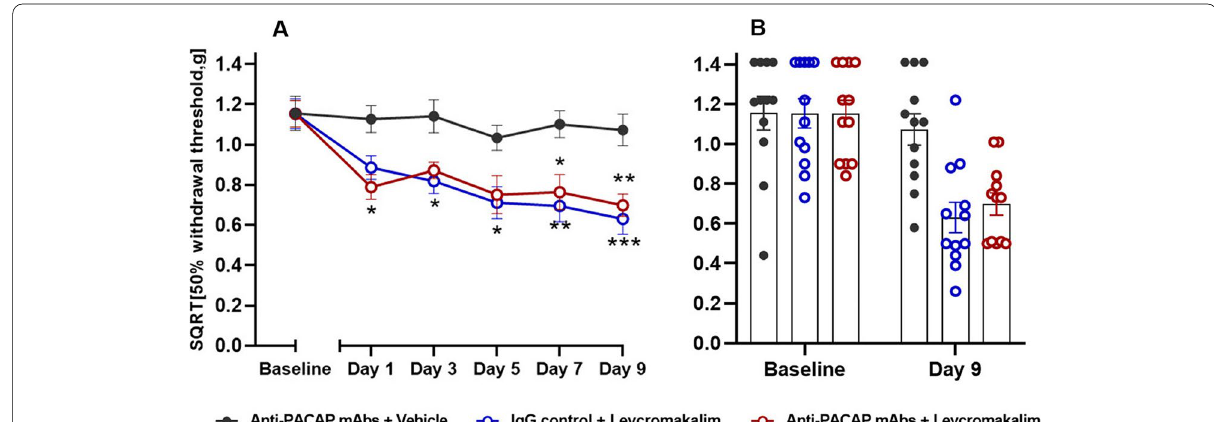
Fig. 4 Levcromakalim signaling independent from PACAP. Data are shown as 50% withdrawal threshold (g) and was square root transformed (SQRT). A Acute responses two hours after levcromakalim (1 mg/kg, i.p.) or vehicle (i.p.) injection in wildtype mice ( n 12 per group) pre‑treated = with anti‑PACAP antibody or IgG control (30 mg/kg, i.p.) on five test days. Two‑way ANOVA with Tukey’s post hoc test for multiple comparisons was used with data represented as means SEMs. * P < 0.05, ** P < 0.01, *** P < 0.001, and **** P < 0.0001. B Descriptive visualization of individual ± = = = = data points for baseline and day 9 of the curves on the left‑hand side (Fig. 4A) with mean bars and